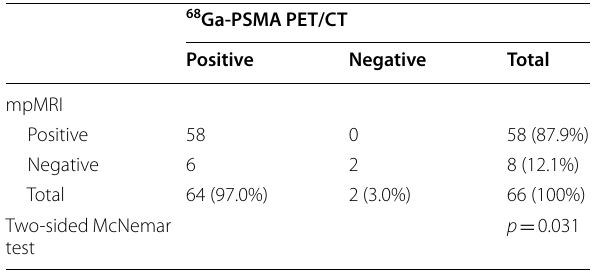
Table 4 Characteristics of the low-risk and intermediate-risk prostate cancer patient population ( n =